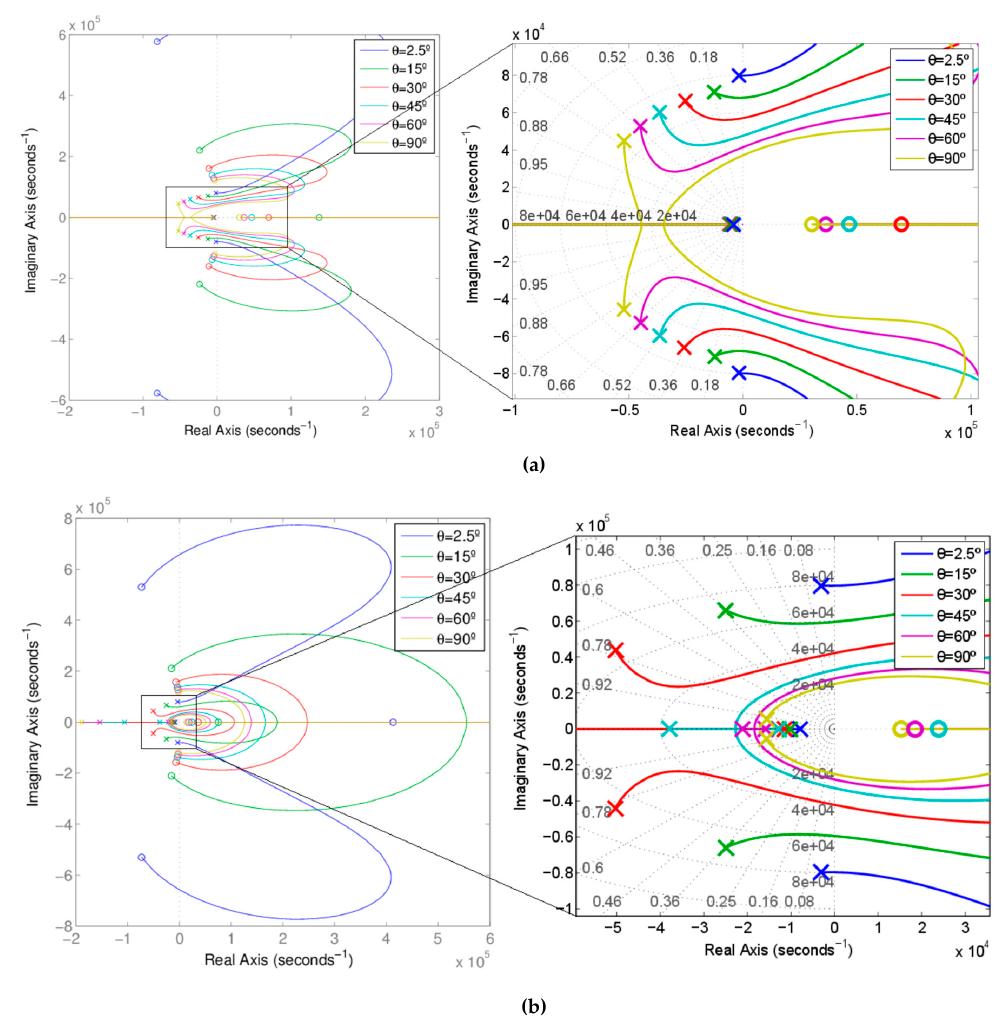
Figure 10. Root locus of 𝑔(cid:3548) (cid:3038) (cid:4666)𝑠(cid:4667) ( a ) for 100 W, ( R = 484 Ω , K 1 = 16.67 A), Figure 10. Root locus of ˆ g k ( s ) ( a ) for 100 W, ( R = 484 Ω , K 1 = 16.67 A); ( b ) for 200 W, ( R = 242 Ω , K 1 = ( b ) for 200 W, ( R = 242 Ω , K 1 = 33.33 A) 33.33